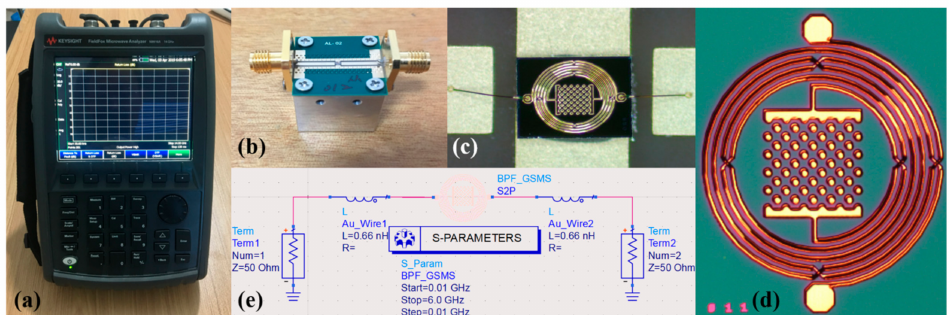
Figure 7. ( a ) Image of the measuring instrument VNA, ( b ) image of the PCB connected to an iron cube with a mounted BPF chip, ( c ) enlarged view of the BPF chip with bonding wire, ( d ) microscope image of the proposed BPF, and ( e ) re-simulation schematic with bonding